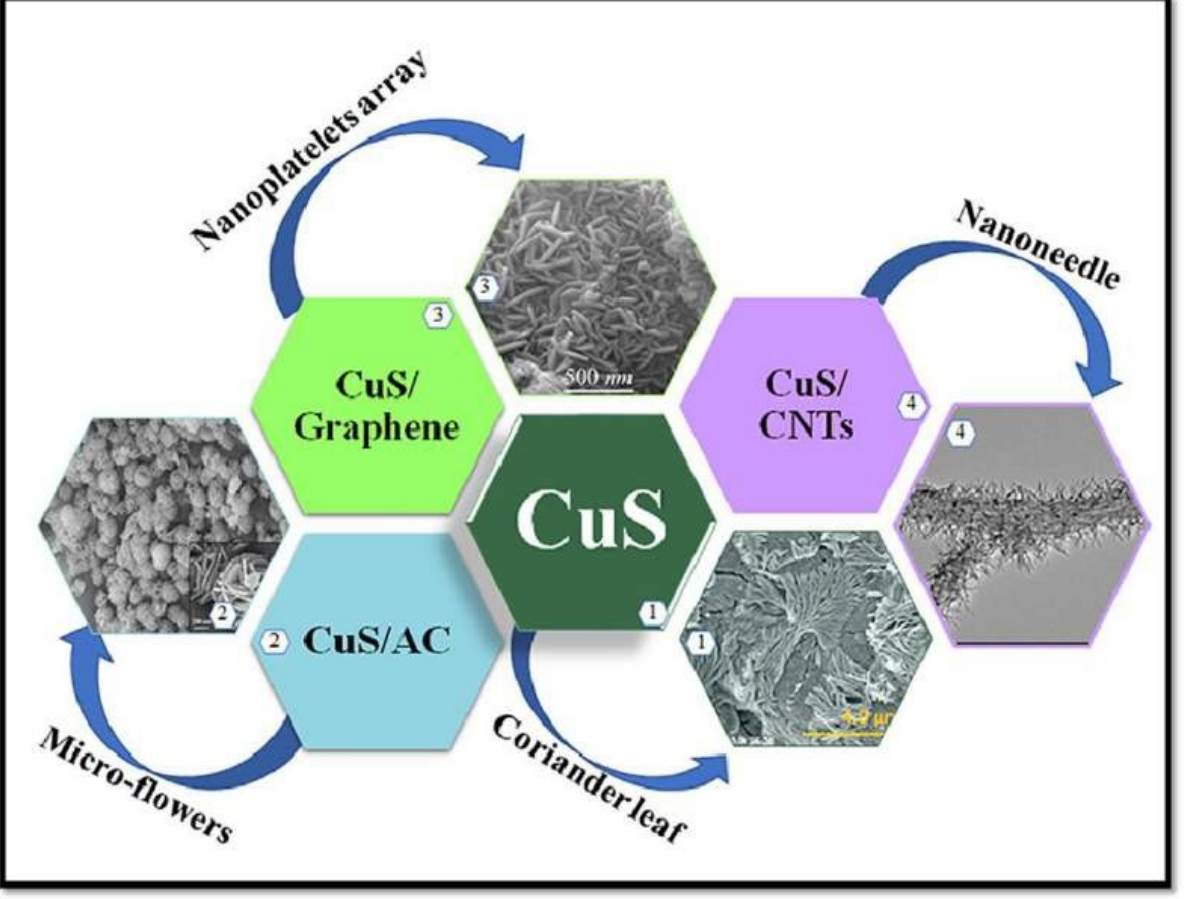
Figure 20. High-energy supercapacitor applications that are driving the development of carbon-based copper sulfide nanocomposites. Reproduced with permission from [94].